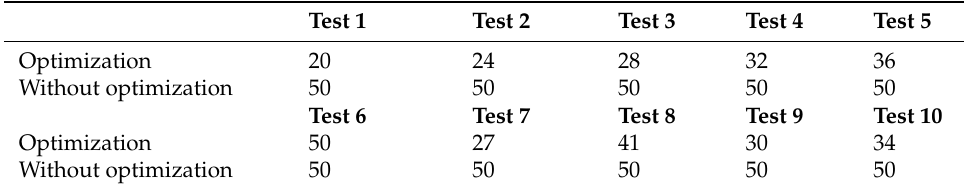
Table 2. Optimization and without optimization’s number of iterations.